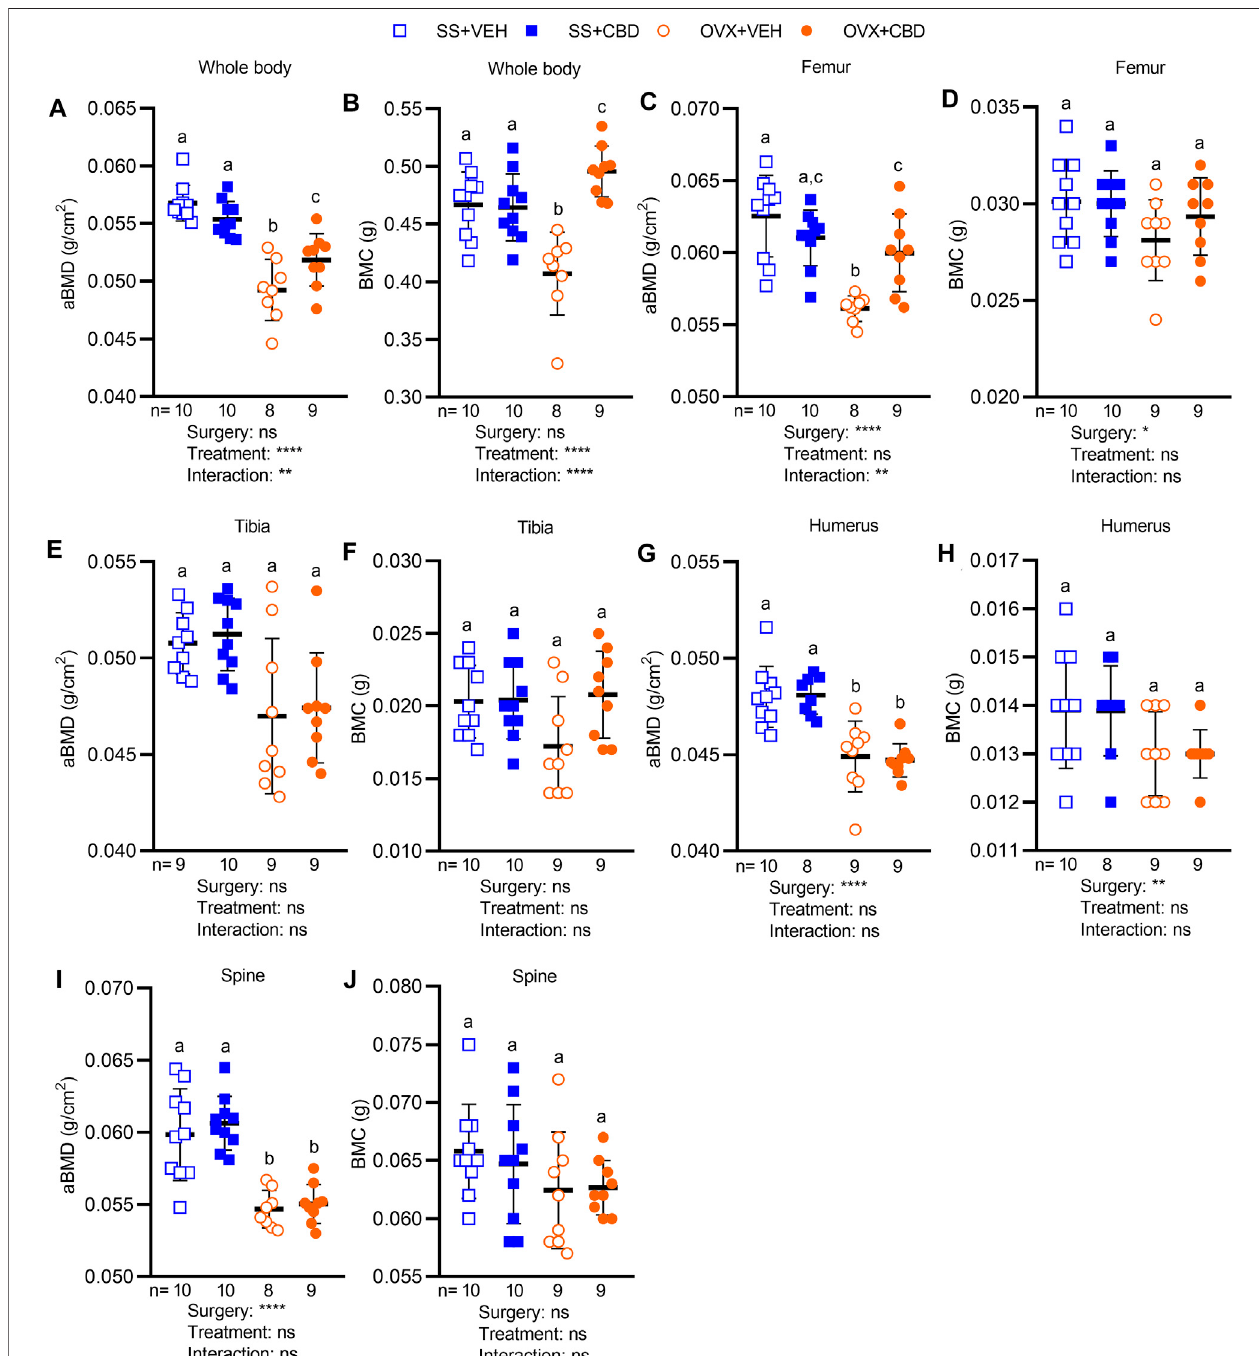
FIGURE 3 | CBD alleviated bone loss in OVX mice. Areal bone mineral density (aBMD) and bone mineral content (BMC) of (A,B) whole body and individual bone samples of (C,D) femur, (E,F) tibia (G,H) humerus, and (I,J) spine as measured by DEXA. Data are presented as mean ± SD and were collected from 9 mice in OVX groupsand10miceinSSgroups,exceptforhumerusdataintheSS+CBDgroupwhere1humerussampleswasnotsuccessfullyexcised.ROUTtestwasperformedto detect outliers. 2-way ANOVA was performed followed by the Benjamini – Hochberg post-hoc test with FDR adjustment, q < 0.05.2-way ANOVA results are indicated under each graph. For posthoc test, different letters (a – c) indicate signi fi cant differences between groups.